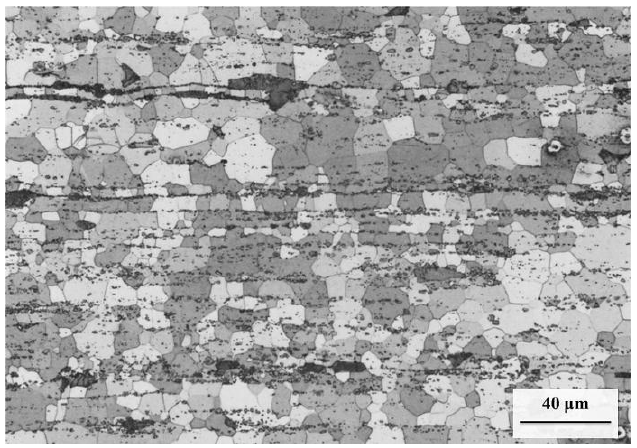
Figure 4. Optical microstructure of the ABaX422 alloy in the extruded condition. The extrusion direction is horizontal.